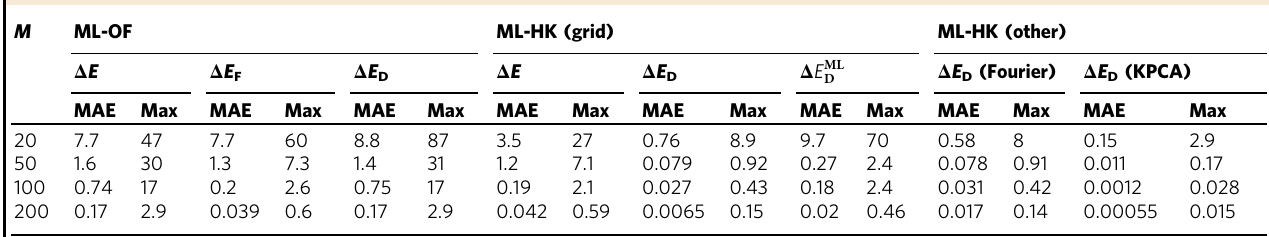
Table 1 Energy errors for the 1D data